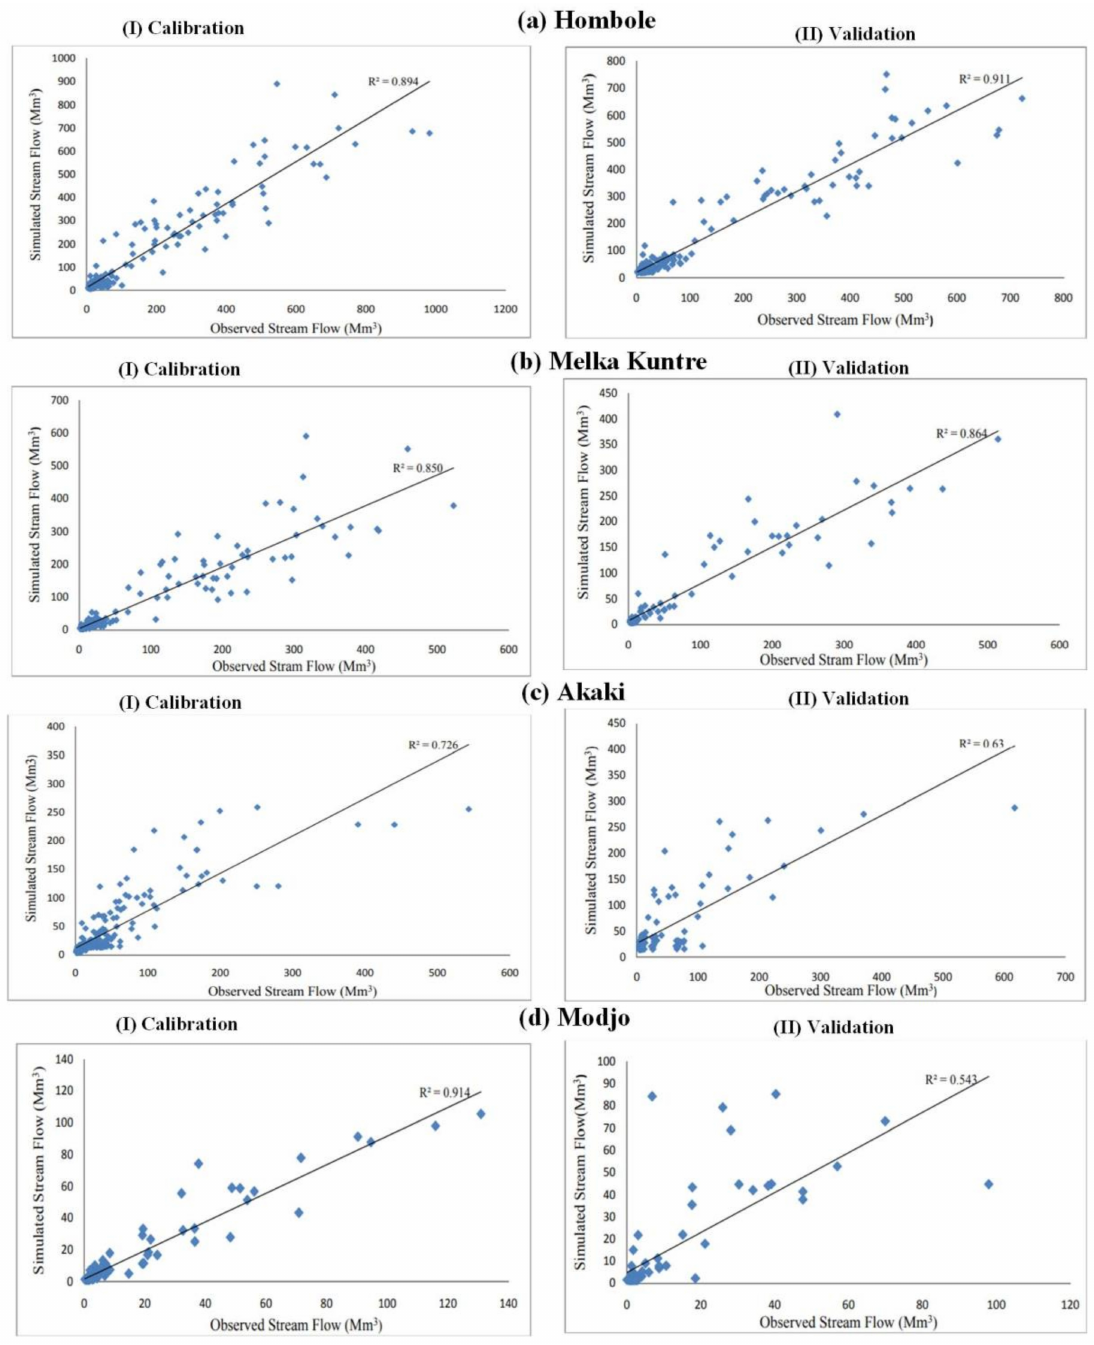
Figure 7. Calibration and validation of the four gauging stations and the entire Awash River